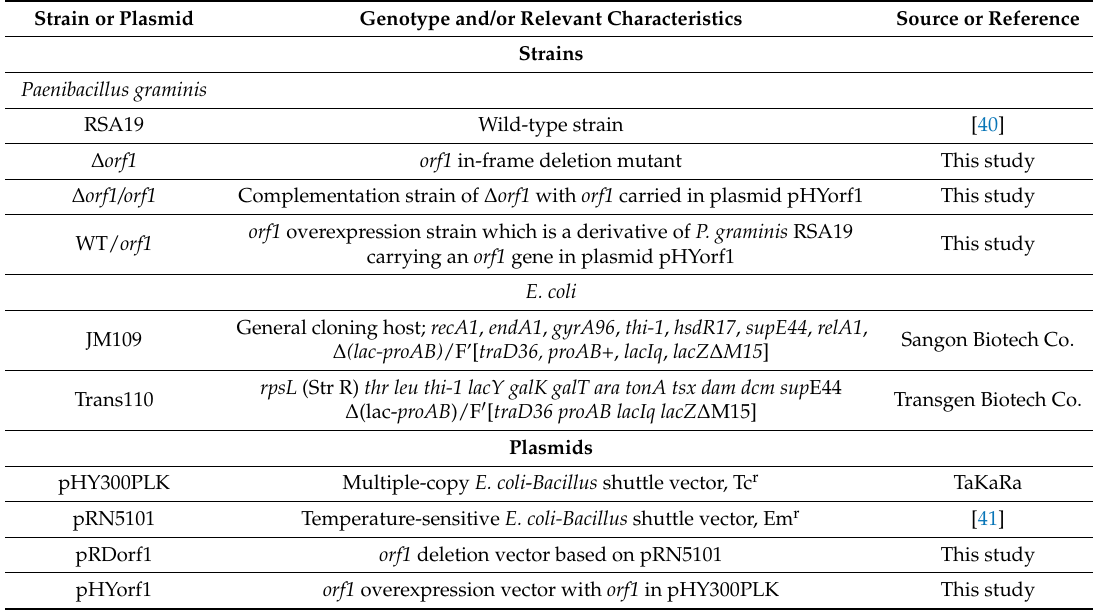
Table 1. Bacterial strains and plasmids used in this